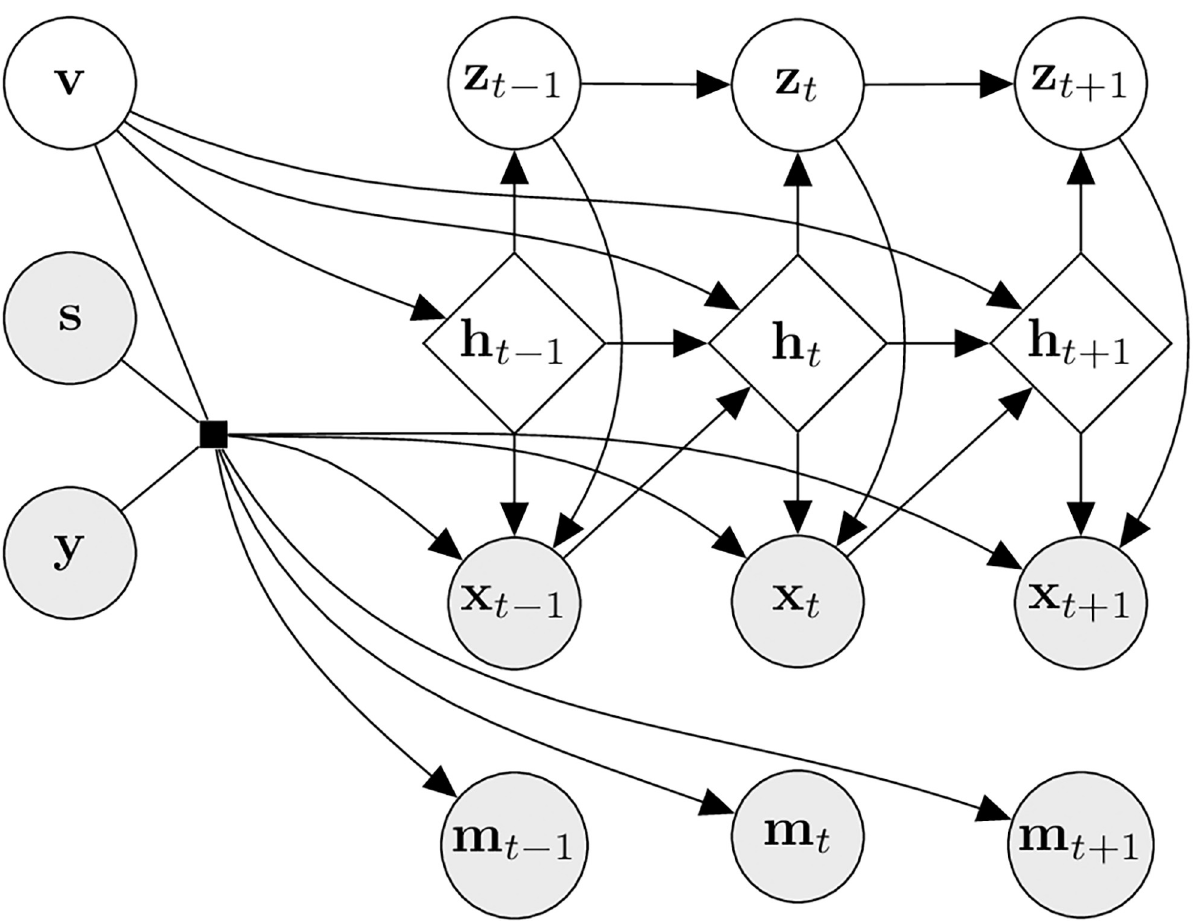
Fig 5. Probabilistic graphical model of the generative process of HealthGen. Diamond shaped nodes represent deterministic variables, round nodes probabilistic variables. Arrows represent direct dependencies. Shaded nodes represent observed or generated variables.